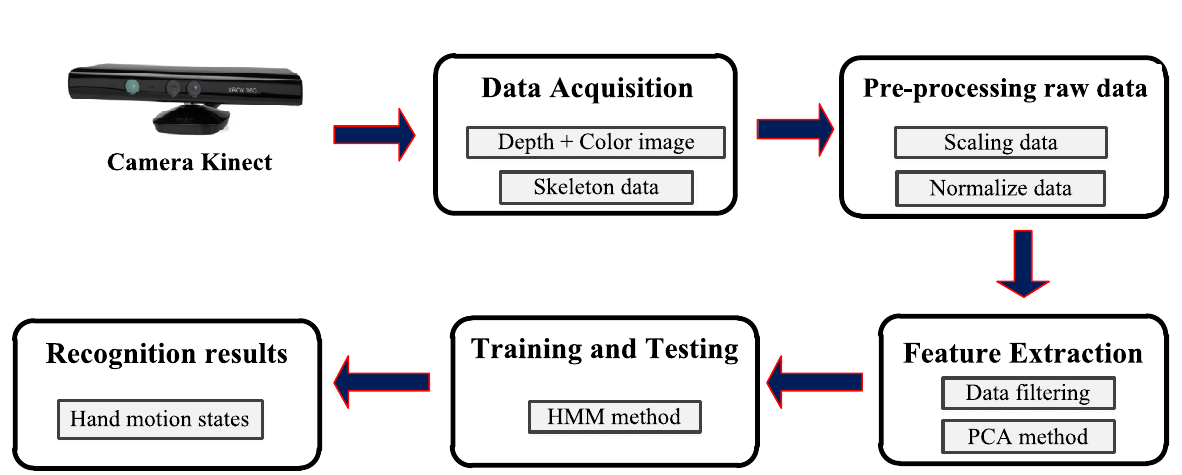
Figure 1. Proposed hand motion recognition system